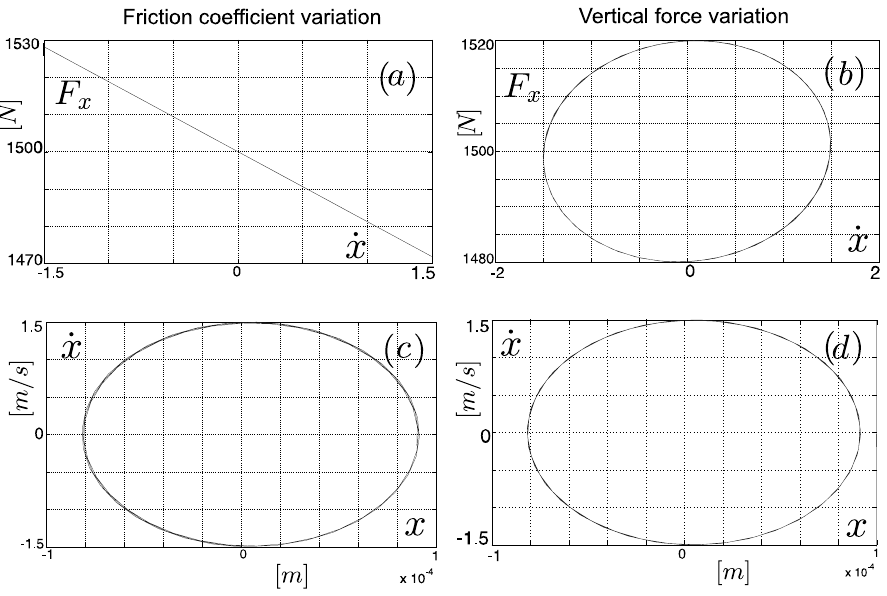
Fig. 3. Self excited vibrations: (a) Speed – friction force and (c) Speed – displacement; forced vibrations: (b) Speed – friction force and (d) Speed –